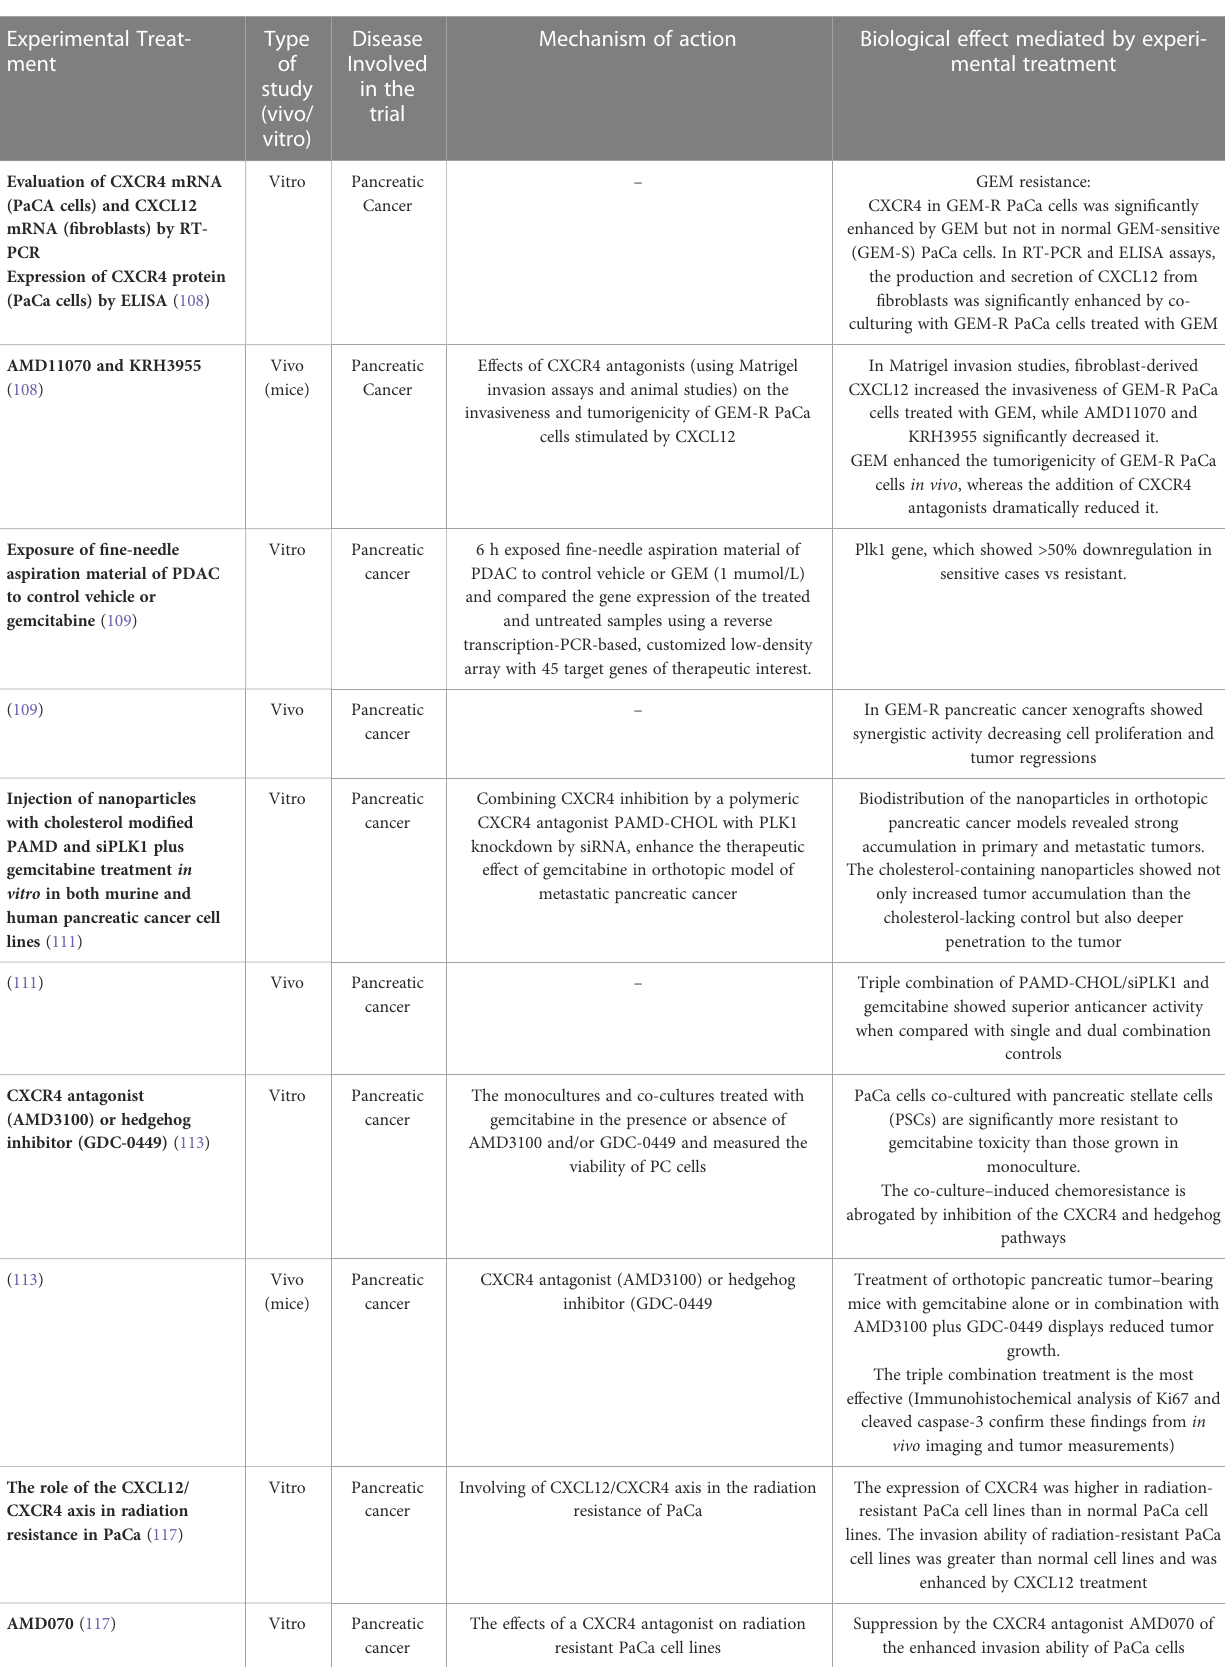
TABLE 1 Preclinical studies about therapeutic option of CXCL12-CXCR4/CXCR7 axis in